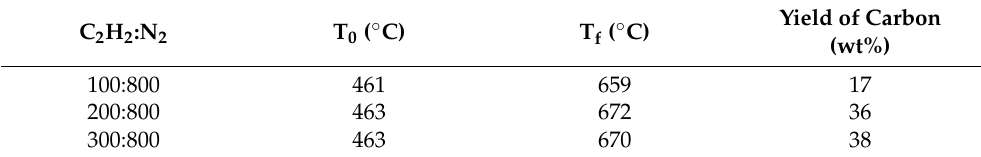
Figure 10. The TGA ( a ) and the Raman spectra ( b ) of SS@CNTs synthesized under various C 2 H 2 flow rates. Table 6. The parameters of TGA of the SS@CNTs synthesized under various C 2 H 2 flow